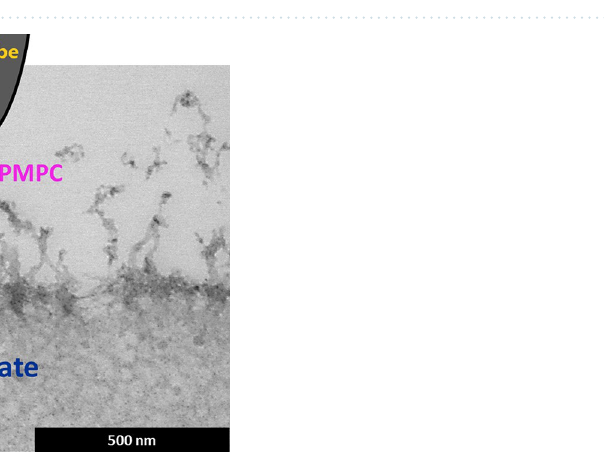
Figure 3. STEM images of cross-sections of ( a ) lehfilcon A CL and ( b ) SiHy Base Substrate. Scale bars, 500 nm. AFM images (3 µm × 3 µm) of the surfaces of ( c ) lehfilcon A CL and ( d ) SiHy Base Substrate.